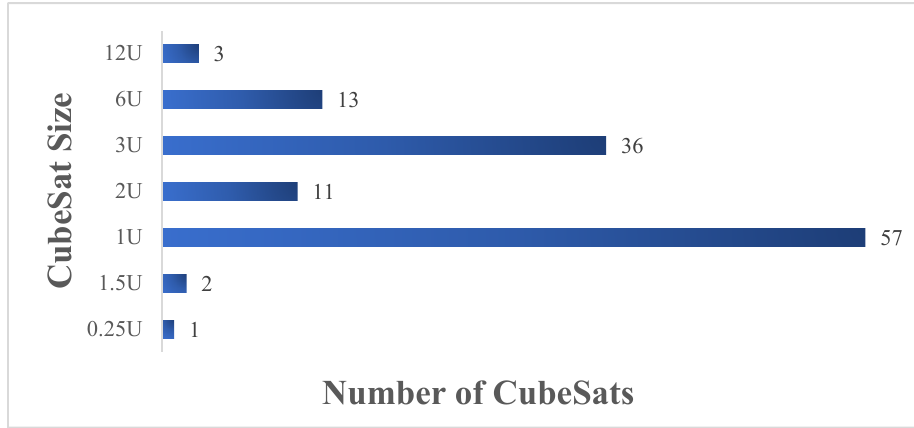
Figure 4. Popular CubeSat sizes used in the 120 CubeSat missions presented in Table 4.